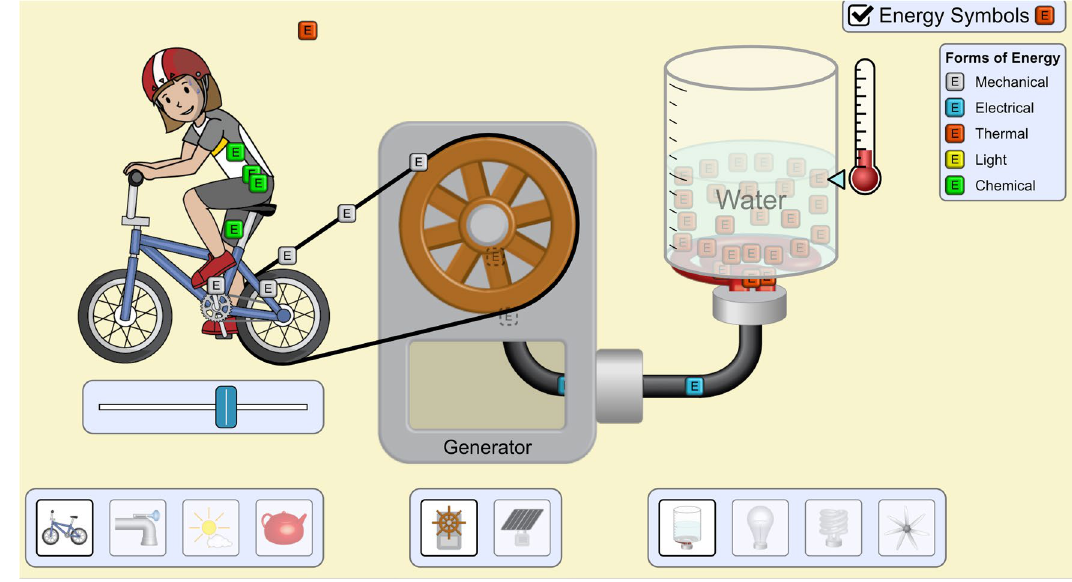
Fig. 4 Snapshot of Energy Conversion